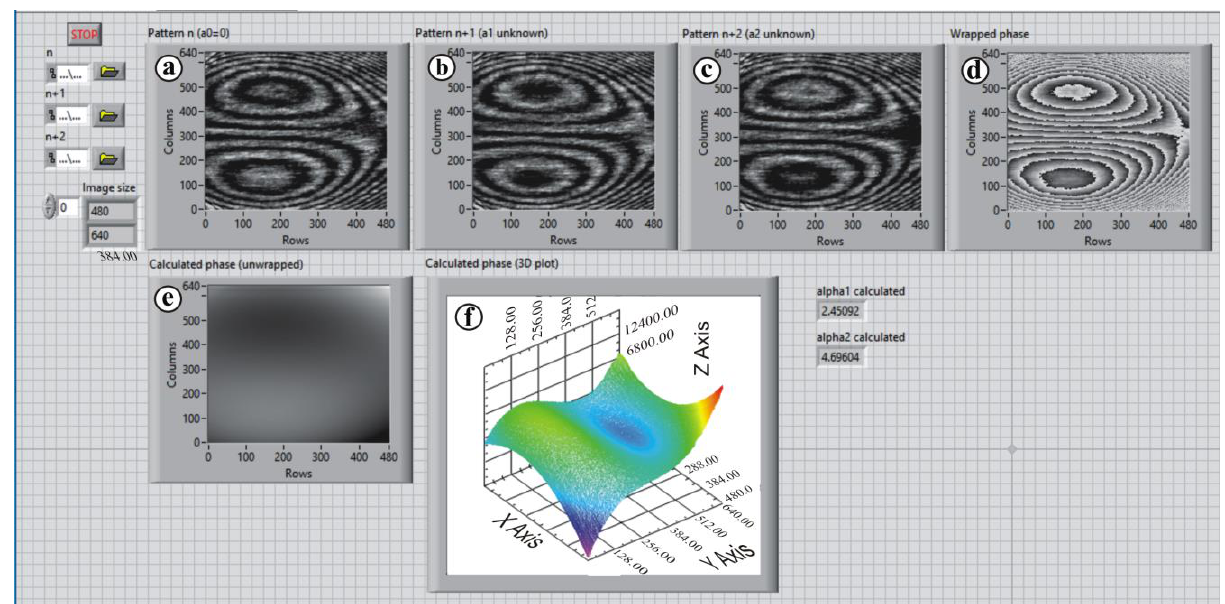
Figure 7. Experimental results: ( a–c ) phase-shifted consecutive experimental interferograms, ( d ) wrapped phase, ( e ) 2D plot unwrapped phase, and ( f ) 3D plot unwrapped phase.